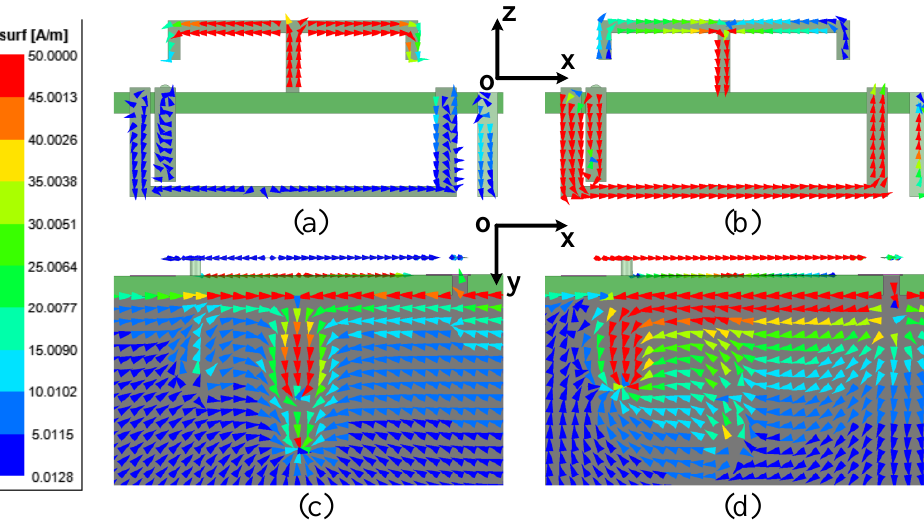
Figure 2. ( a ) Current distribution on the antenna when Port1 is excited at 3.5 GHz (monopole mode). ( b ) Current distribution on the antenna when Port3 is excited at 3.5 GHz (dipole mode). ( c ) Current distribution on the ground when Port1 is excited at 3.5 GHz (monopole mode). ( d ) Current distribution on the ground when Port3 is excited at 3.5 GHz (dipole mode).